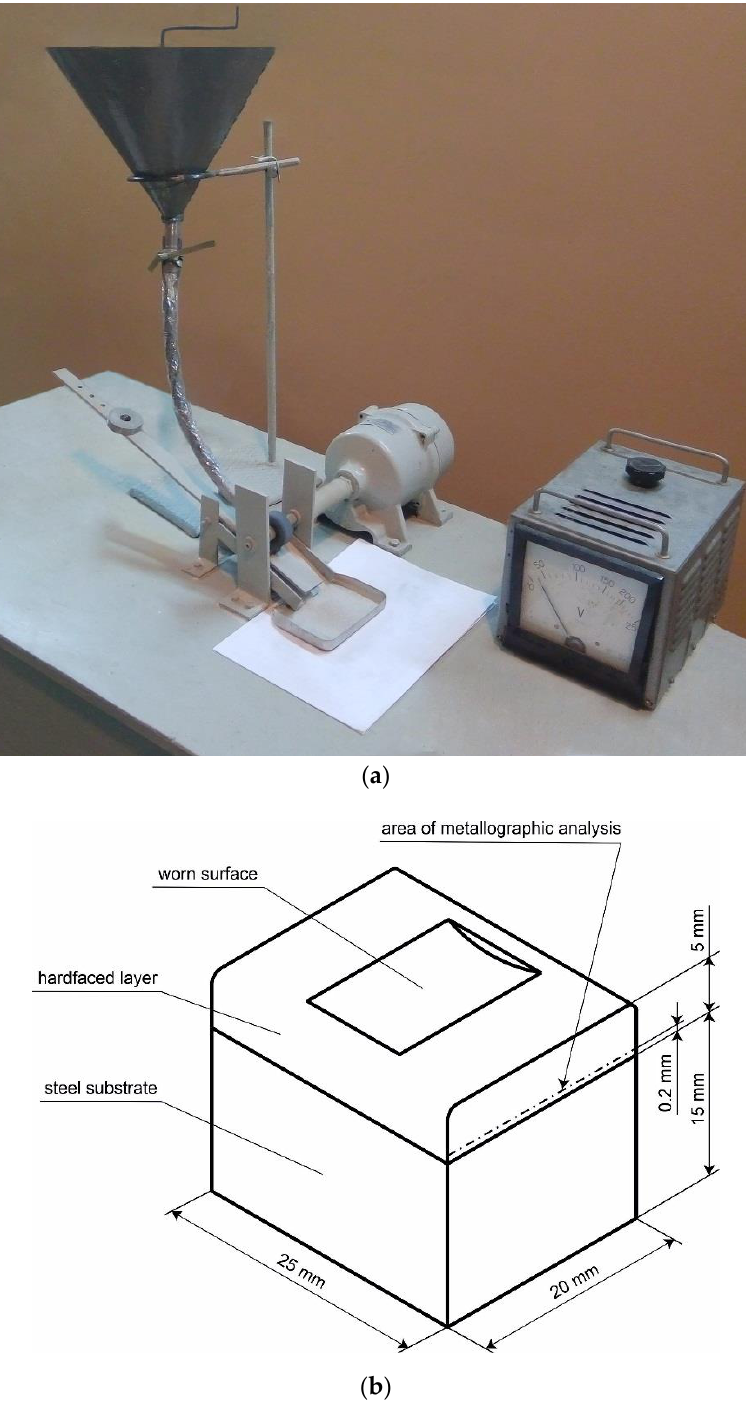
Figure 2. General view of the dry sand and rubber wheel abrasion testing machine ( a ) and flat sample with hardfacing layer ( b ).